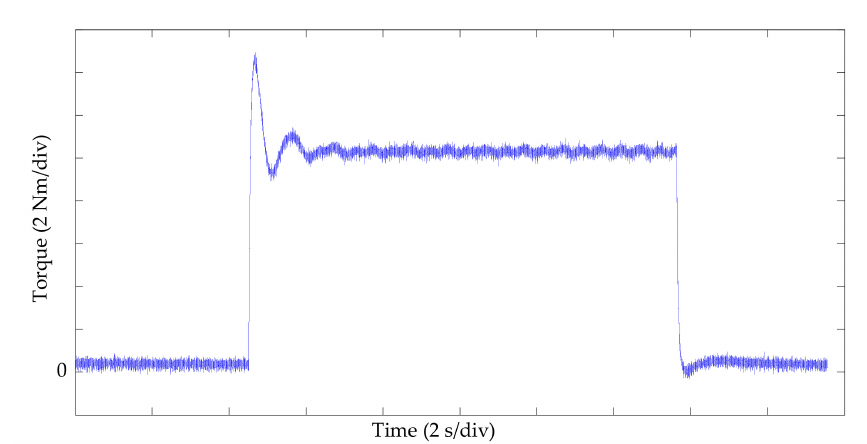
Figure 13. The process of the step response of torque.